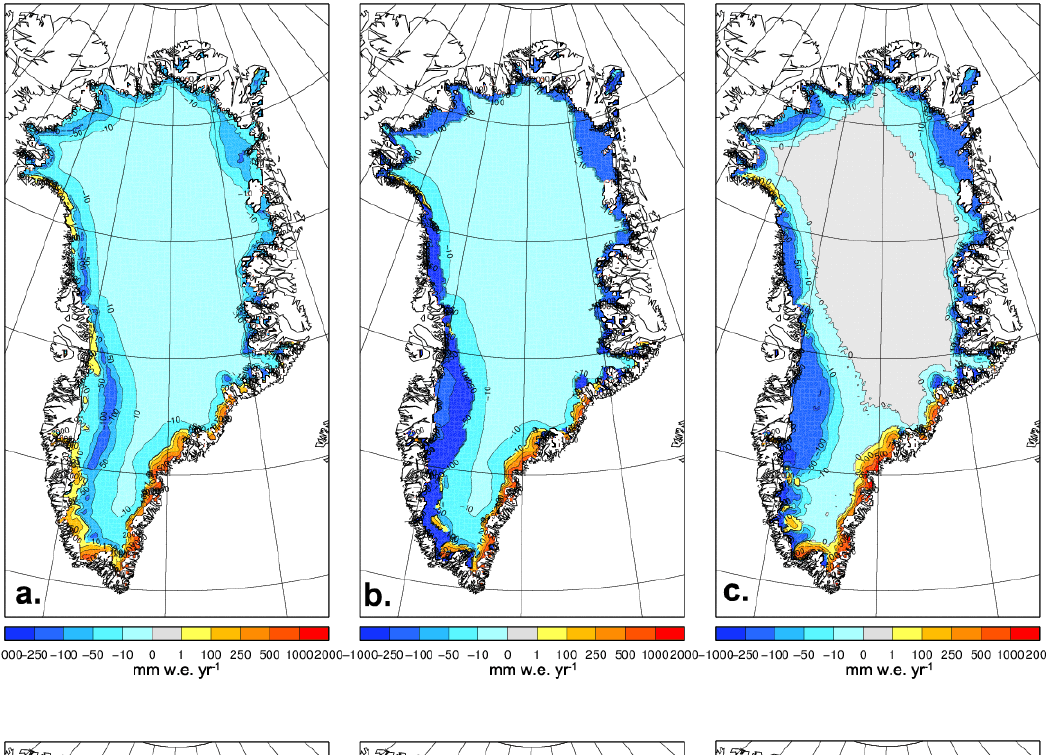
www.the-cryosphere.net/6/743/2012/ The Cryosphere, 6, 743–762,